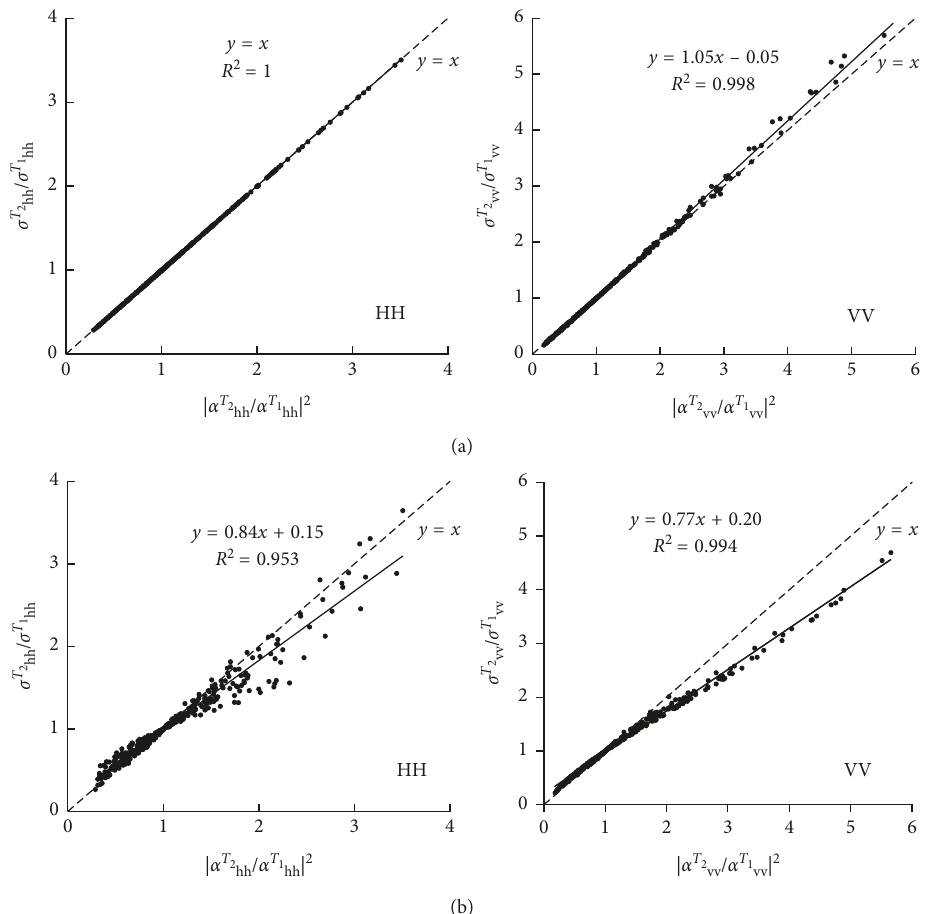
T 1 2 and σ T 2 α T 2 pp / α T 1 pp pp / σ pp simulated by IEM and Oh models. (a) Comparison between σ | | 2 . (b) Comparison between σ T 2 α T 2 pp / α T 1 pp | | 2 α T 2 pp / α T 1 pp | |